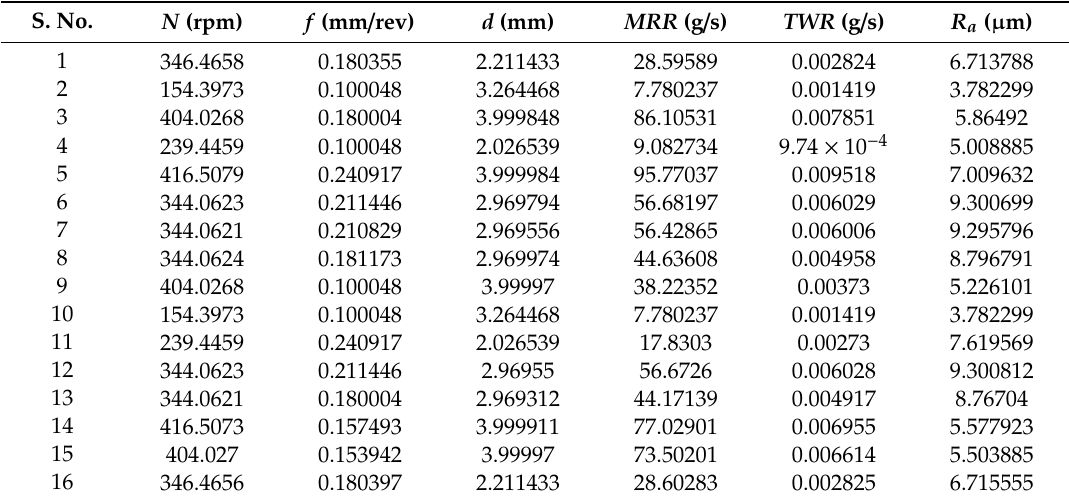
Table 13. Optimized design space of cutting parameters and corresponding output responses.